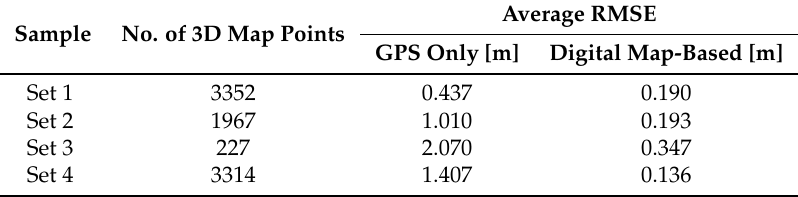
Sample No. of 3D Map